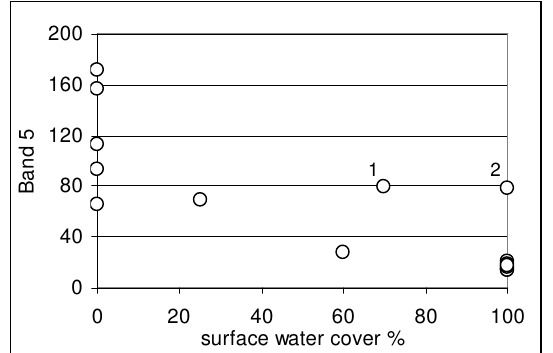
Figure 2: Regression of Band 5 values and percent surface water